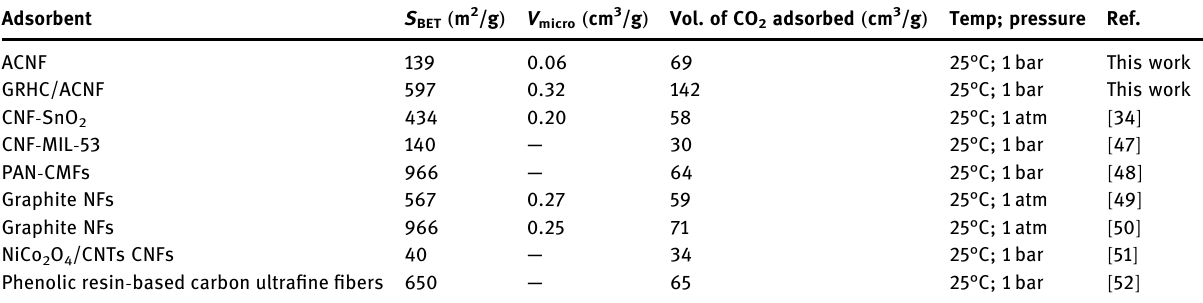
Table 6: Comparison of CO 2 adsorption capacity on various types of carbon fi bers and their composite - based adsorbents